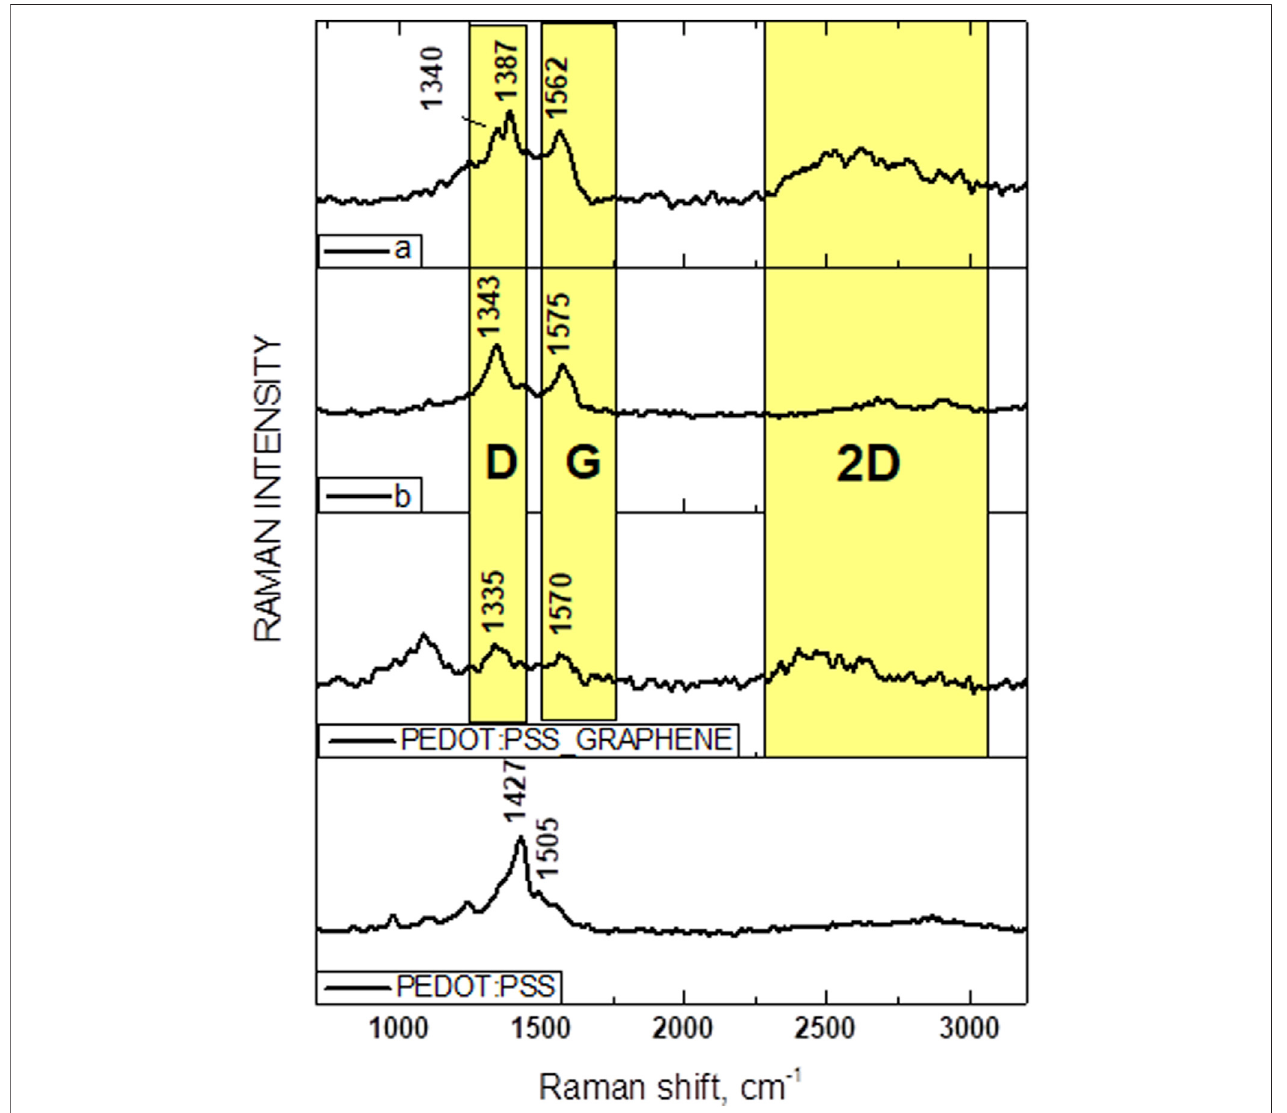
FIGURE 3 | Raman spectra of the PEDOT:PSS fi lm without graphene, PEDOT:PSS-graphene, PEDOT:PSS-graphene- a complex, and PEDOT:PSS-graphene- b complex fi lms.